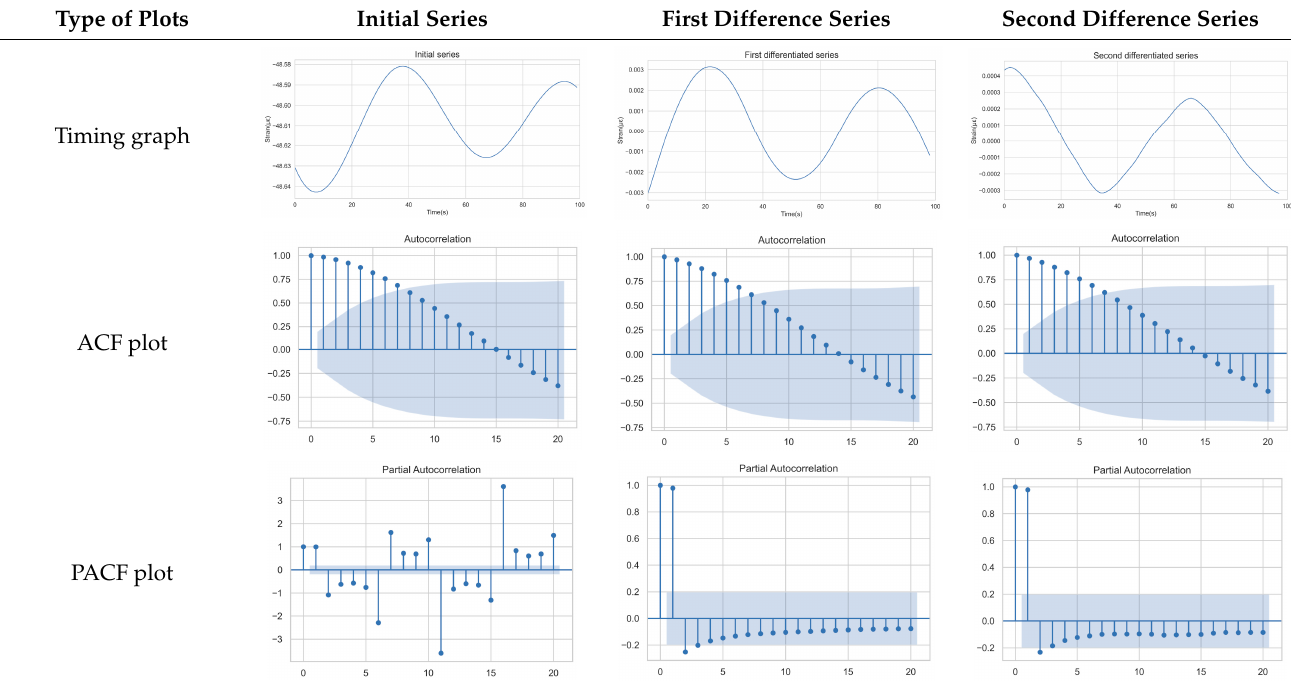
Table 2. Timing graph, ACF, and PACF of differenced series.